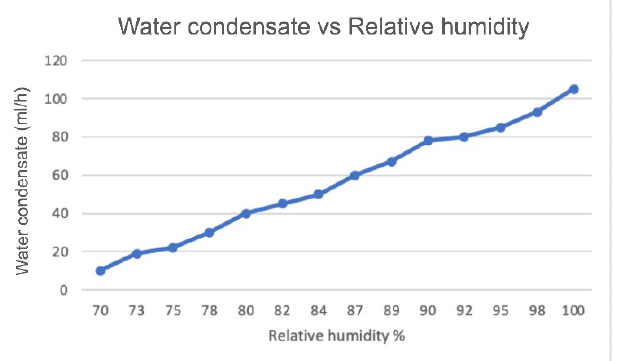
Figure 6. Amount of water produced (in mL/h) as a function of relative humidity considering an air flow rate of 0.0117 kg/s and I of 1.349 A. Reproduced from Eslami et al. [18].